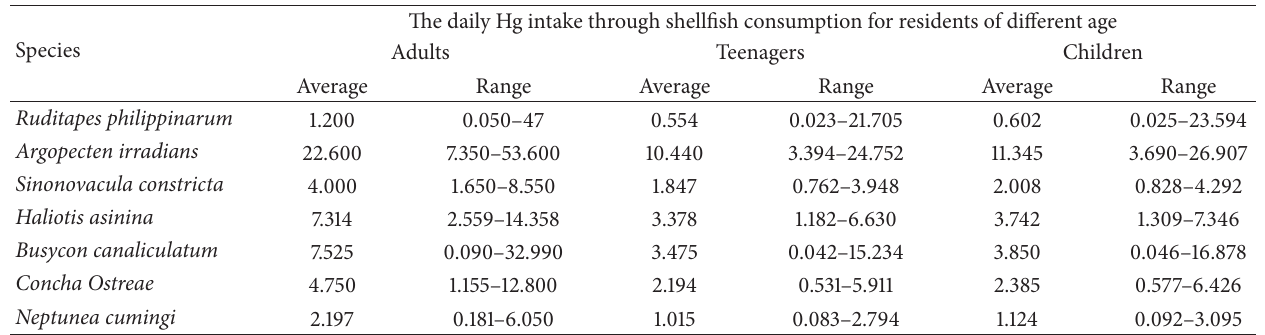
Table 4: Hg intake to residents of different age groups near northern Jiaozhou Bay by shellfish consumption values ( 𝜇 g ⋅ d − 1 ). Species